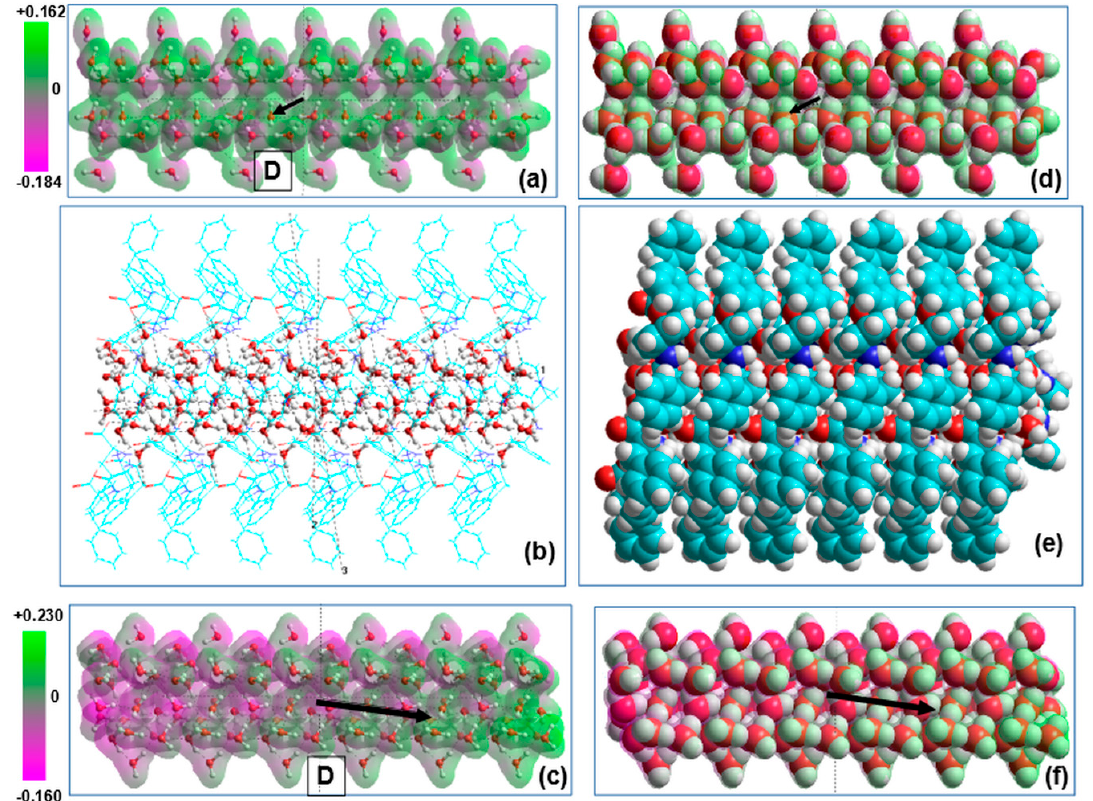
Figure 8. Model images of the water/ice tubular nanostructures and D-FF PNT with filled hydrophilic cavity, consisting from six repeated coils along the c-axis (in X-projection): ( a ) initial tubular water/ice structure, ( b ) D-FF PNT with embedded water/ice structures under optimization process, ( c ) water/ice tubular helix structure after optimization inside D-FF PNT, ( d ), ( e ), and ( f ) the same in the VdW surface presentation. Vector D show the direction of the total dipole momentum in the initial (D ~ 1 Debye) and optimized water/ice cluster (D ~ 97 Debye). Translucent 3D-mapped isosurface on ( a ) and ( c ) (as well as on ( d ) and ( f )) illustrates the re-distribution of the electrostatic potential of water/ice cluster before and after optimization within D-FF PNT.